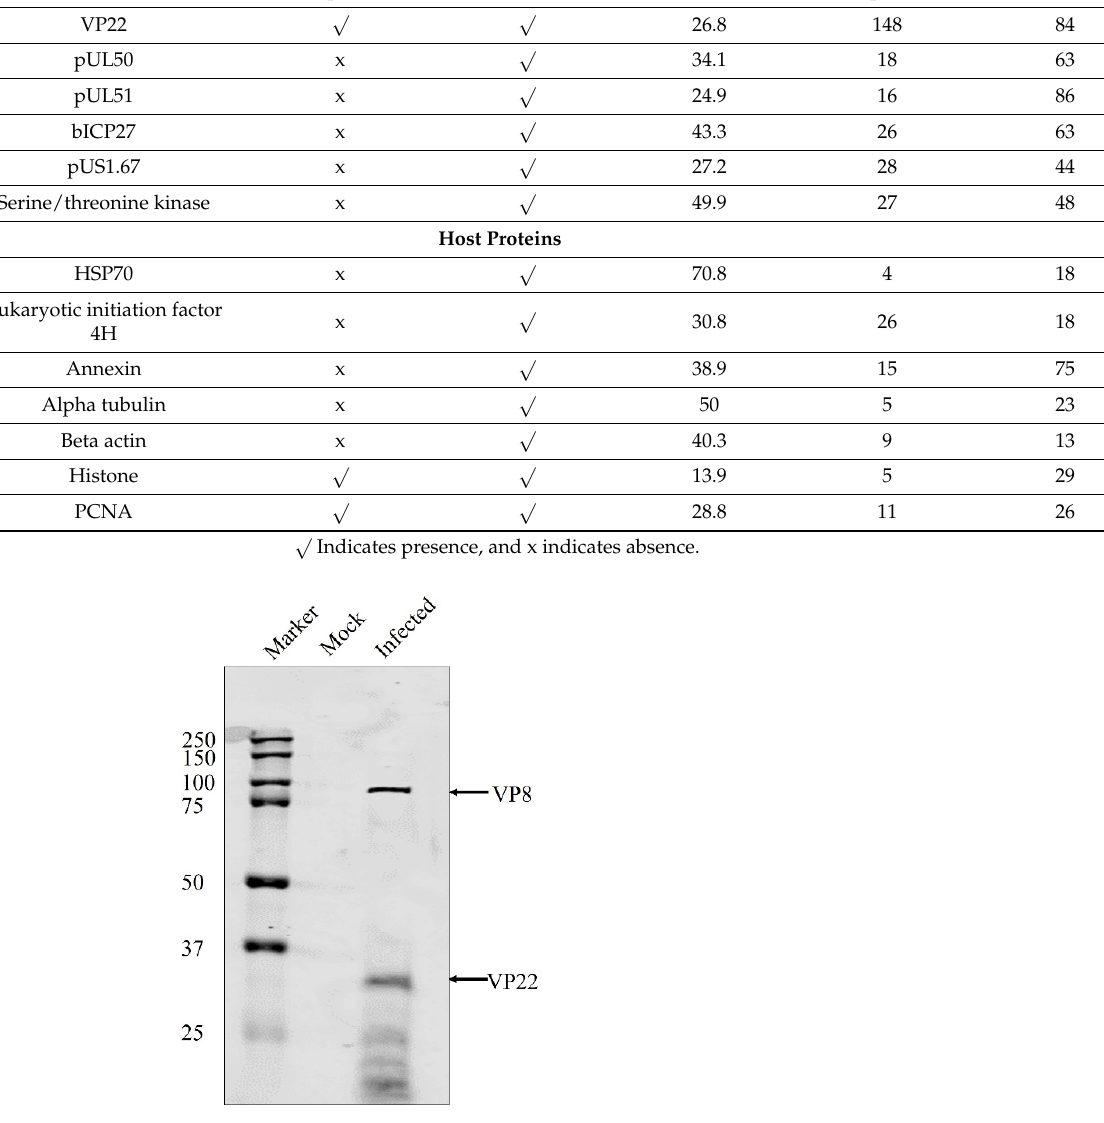
Figure 3. Identification of VP8 and VP22 in primary enveloped virus purified from the NMP of MDBK cells infected with wild-type BoHV-1 at an MOI of 10 and harvested 7 h post-infection. The proteins were separated by SDS-PAGE on 8% reducing gels, and VP8 and VP22 were identified by Western blotting with mouse VP8-specific monoclonal antibody and rabbit VP22-specific polyclonal antibody, followed by IRDye 680RD goat anti-mouse IgG and IRDye 800RD goat anti-rabbit IgG, respectively. The positions of the tegument proteins VP8 and VP22 are indicated with arrows. Molecular weight markers (MWs) ×10 − 3 are shown in the left margin.